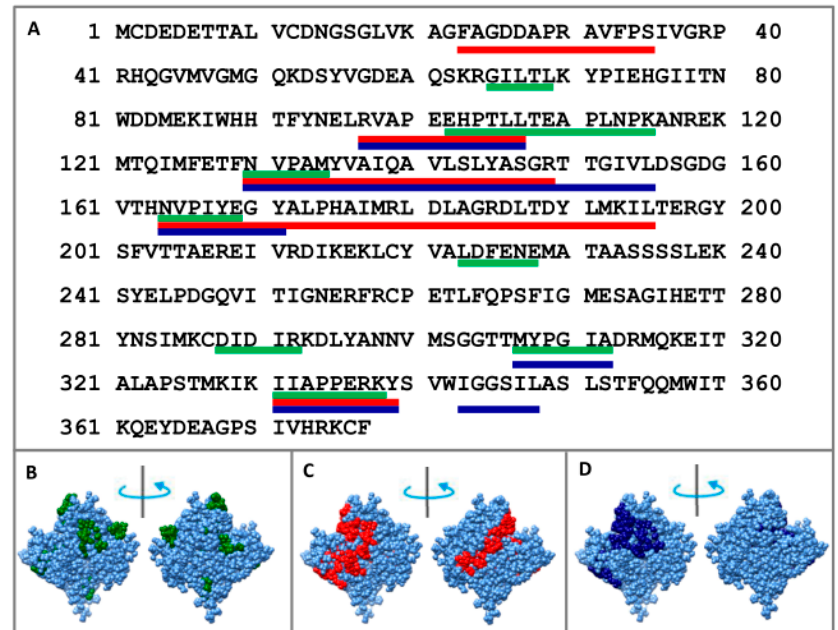
Figure 4. Mass spectrometry analysis of the monomer actin regions protected to the proteolysis treated with mixture of proteases (green lines: 65–69, 102–115, 130–134, 164–167, 223–228, 288–292, 308–312, and 331–338); mass spectrometry analysis of F ‐ actin regions protected to the proteolysis treated with proteinase K (red lines: 23–35, 97–107, 130–149, 164–195, and 331–339) and treated with the mixture of proteases: trypsin, chymotrypsin and proteinase K (blue lines: 97–107, 130–155, 164–171, 307–312, 331–339, and 343–348) indicated on the primary ( A ) and spatial ( B – D ) structures of actin.